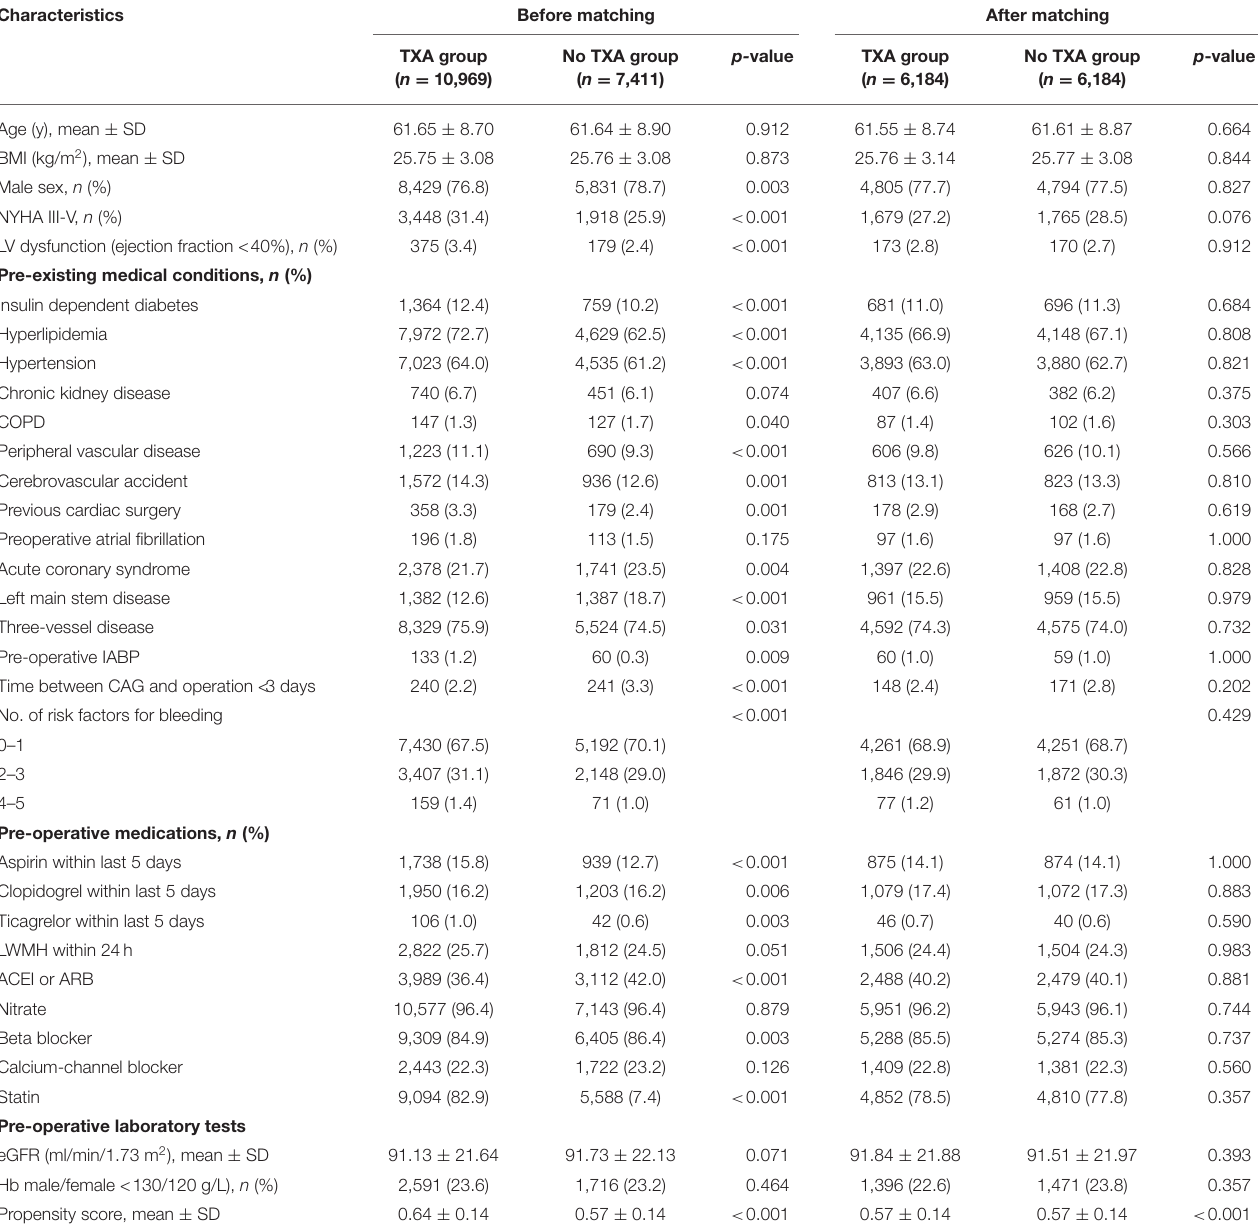
TABLE 1 | Baseline information for OPCAB patients with or without TXA in the entire cohort before and after propensity score matching.